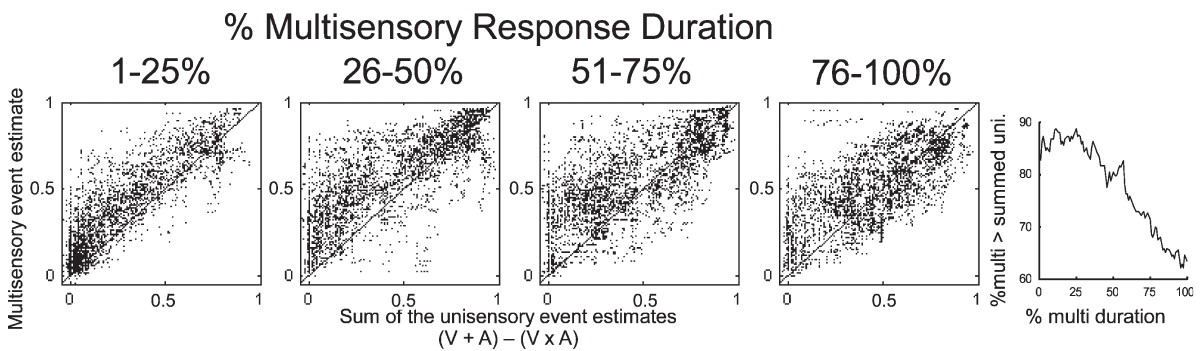
Figure 6. Initial response enhancement . The multisensory event estimate was compared to the sum of the two unisensory estimates (minus their product) in different stages of the multisensory response (240 multisensory responses sampled with 1ms resolution). In the first quarter, multisensory event estimates were usually (87% of the time) greater than the sum of the unisensory estimates. This elevation was maintained in the second quarter, where multisensory event estimates exceeded the unisensory sum 83% of the time. The final two quarters showed increasing parity between the multisensory and summed unisensory event estimates (3rd ¼ 75%, 4th ¼ 65%). The figure on the right provides the incidence of multisensory event estimates greater than the unisensory sum over the duration of the multisensory response (1–100% in 1% steps). Initially more than 85% of multisensory estimates exceeded the sum, but at the end of the response, less than 65% did